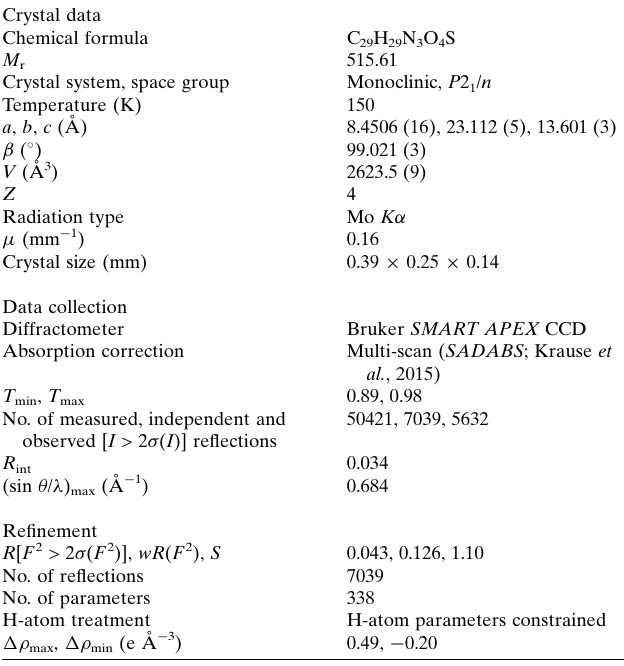
Table 3 Experimental details. Crystal data Chemical